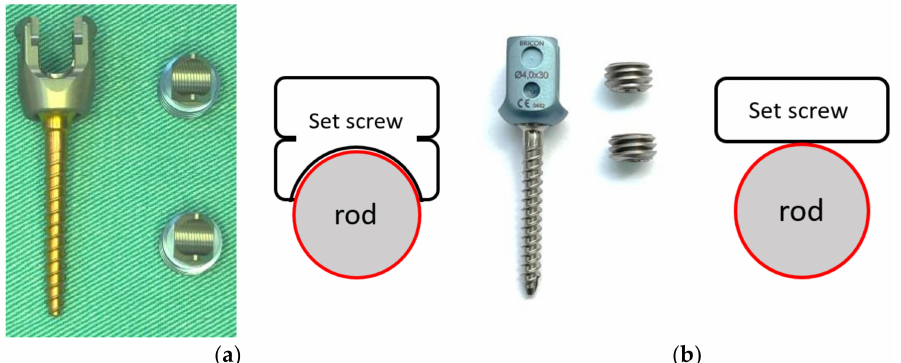
Figure 1. ( a ) MATRIX Spine System; plane contact surface between set screw and rod. ( b ) OC- TOPODA Spine System; line contact surface between set screw and rod.